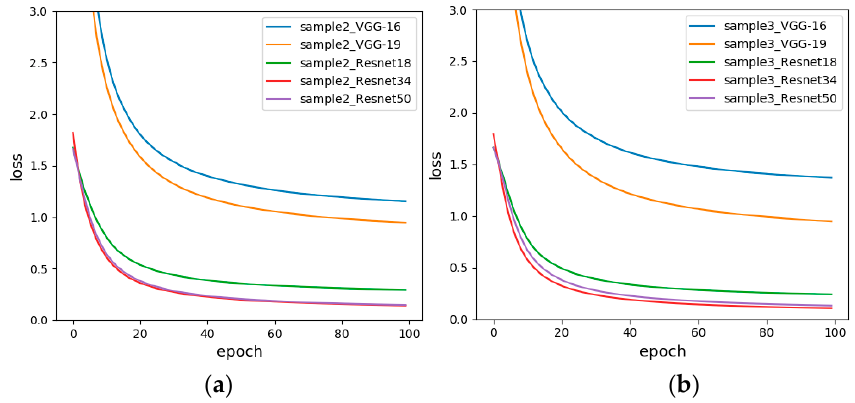
Figure 12. The loss functions before and after data standardization ( a ) Sensor baseline non-standardized (Sample-set 2); ( b ) Sensor baseline standardized (Sample-set 3).